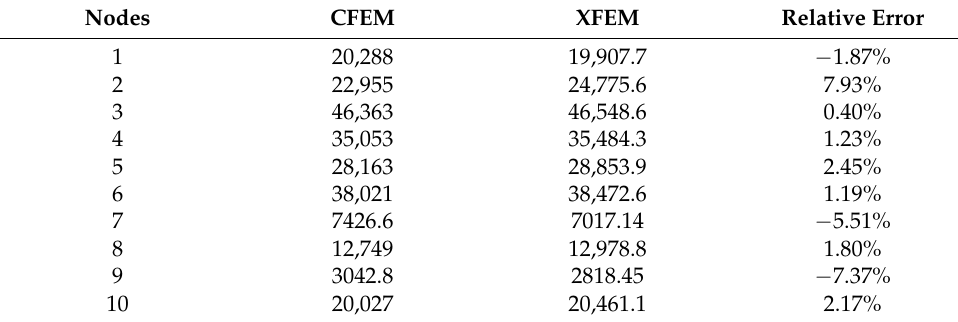
Table 8. Contrast of the results of nodes near interface.